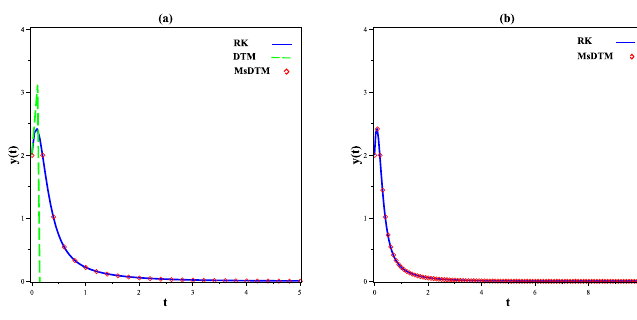
Figure 9: The density of the birds infected with avian influenza with r 0 = 0.9 and R 0 ≈ 7.1